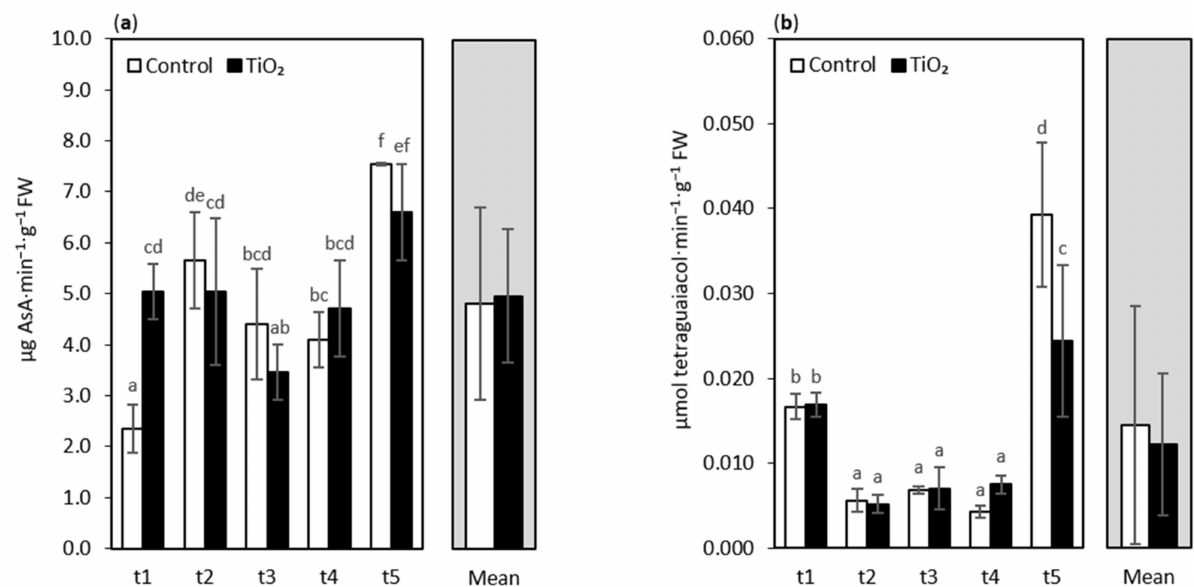
Figure 4. Ascorbate peroxidase (APX) activity ( a ) and guaiacol peroxidase (GPOX) activity ( b ) of oakleaf lettuce seedlings treated with TiO 2 -NPs applied on the leaves as a 0.75% suspension, while control plants were sprayed with deionized water. Plants were sampled 4, 7, 9, 11, and 13 days after treatment (sampling time: t1, . . . , t5, respectively). Lower-case letters above bars highlight significant differences for interaction effects, according to Fisher’s test ( p ≤ 0.05). Missing letters indicate no significant differences. Error bars represent standard deviations ( ±